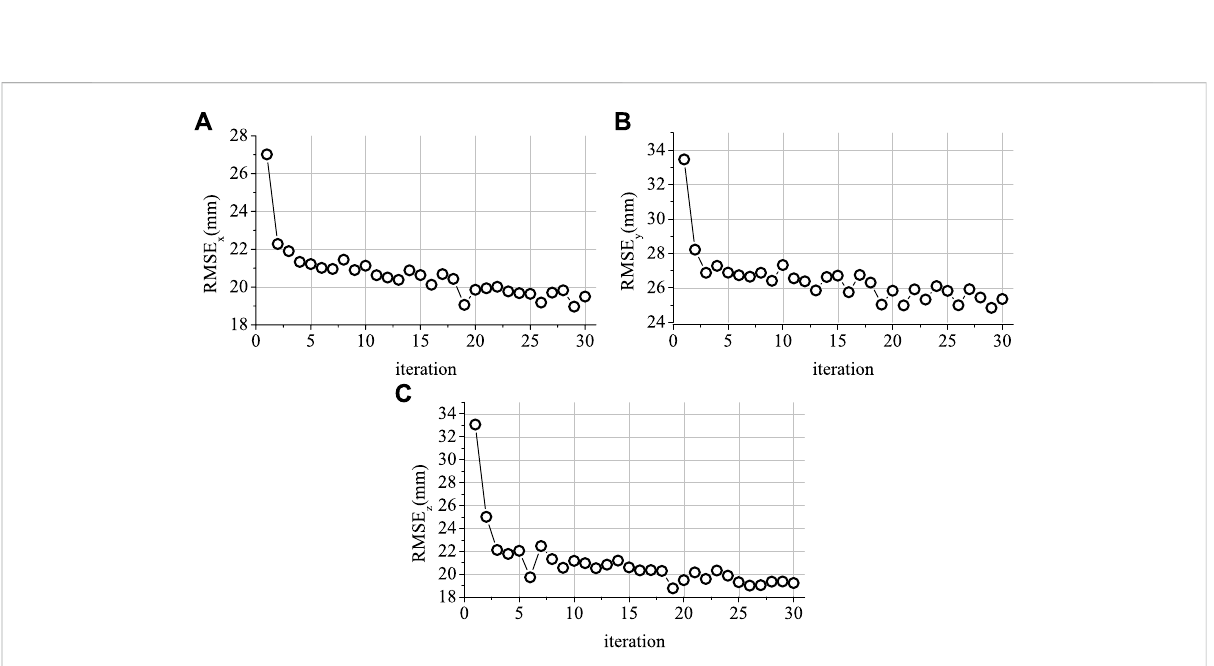
FIGURE 8 RMSE tracking errors. (A) RMSE in X coordination. (B) RMSE in Y coordination. (C) RMSE in Z